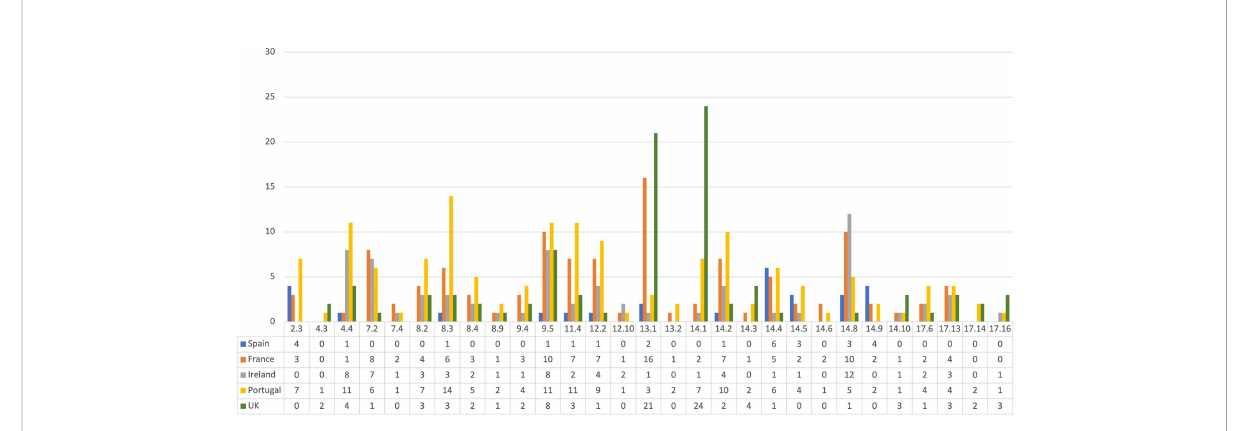
FIGURE 12 Number of measures by the target of the selected SDGs, for the fi ve case studies. Source: Created by the